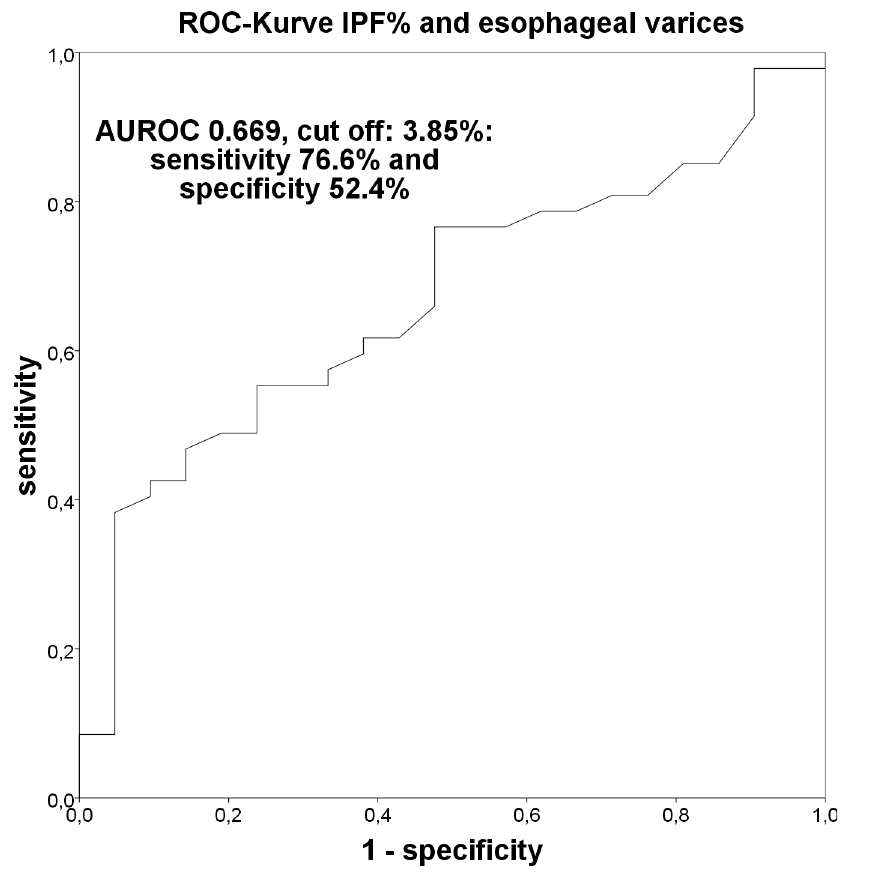
Fig 6. Receiver operating characteristics curve: IPF% and esophageal